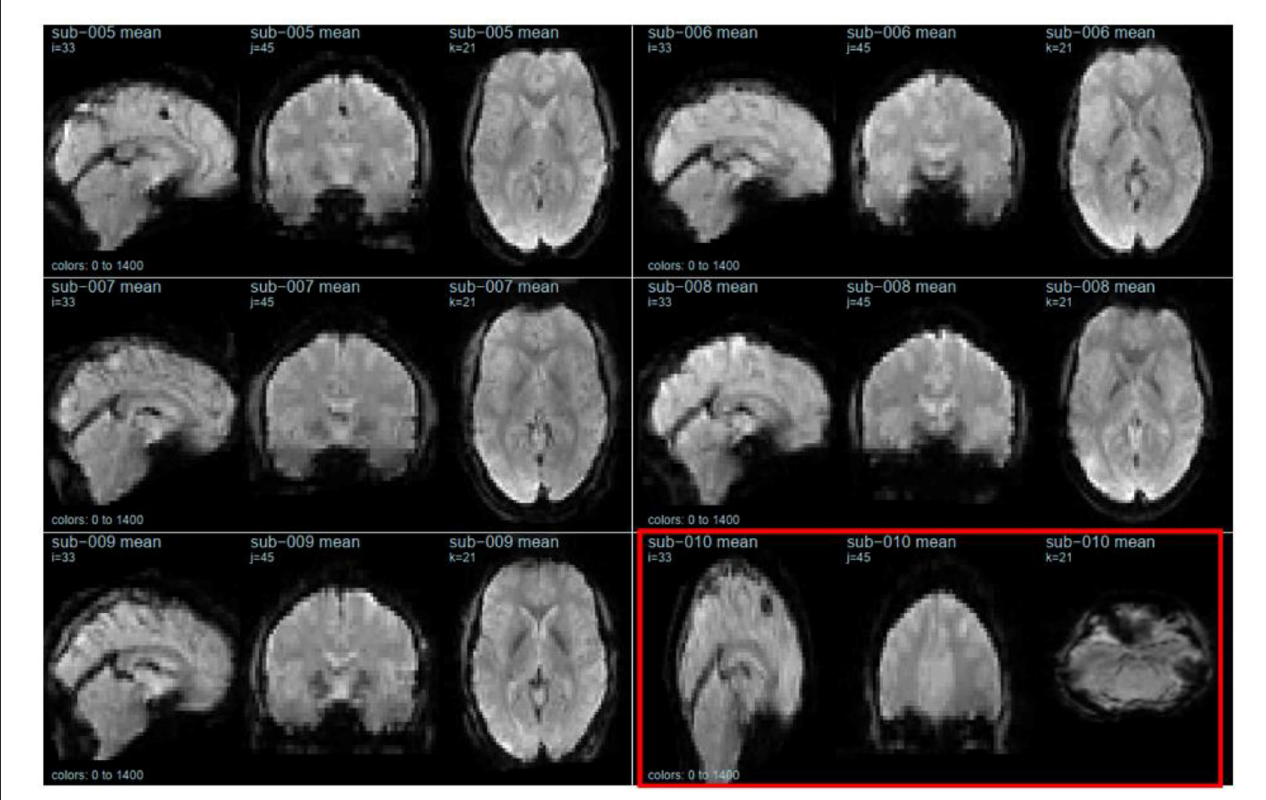
FIGURE1 Temporal mean images for six participants, calculated after preprocessing. sub-010 (outlined in red) is highly distorted. This figure is from page 12 of openQC_fMRIQC.pdf.